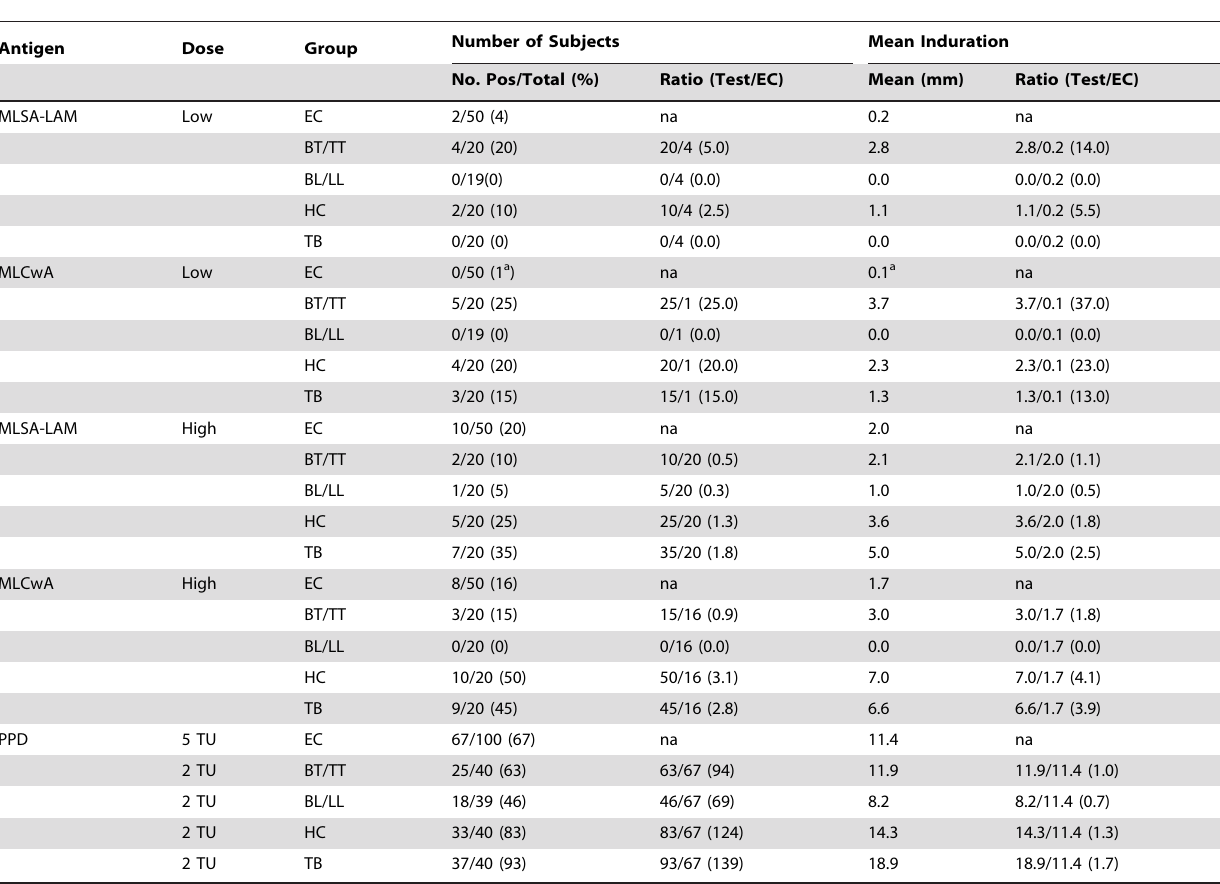
Table 2. Number of positive responders and mean induration compared to ECs.